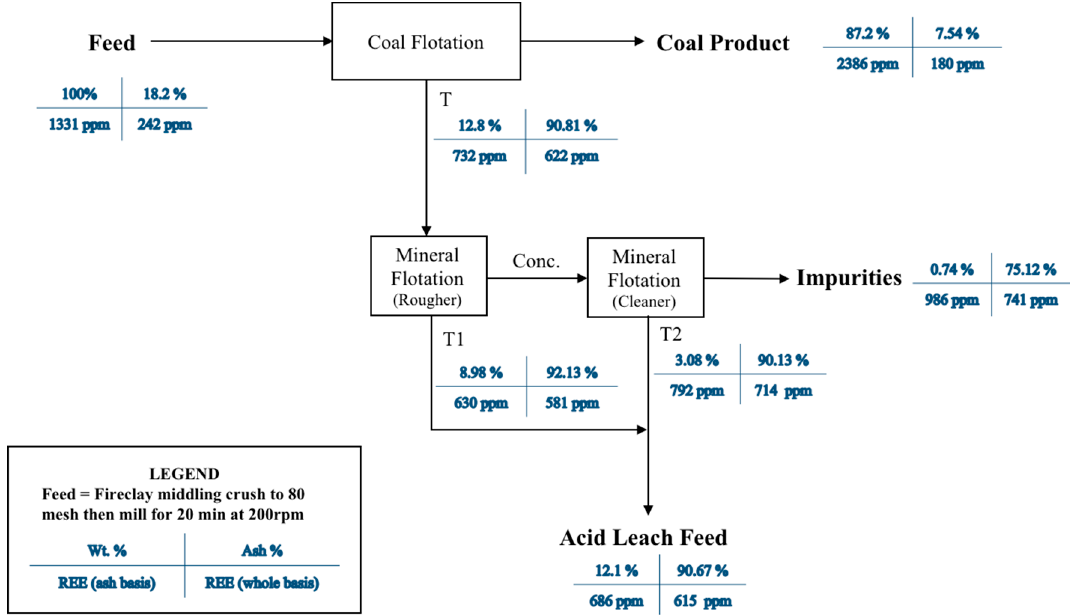
Figure 3. Schematic of sample preparation for the acid leach feed material using coal and mineral flotation.